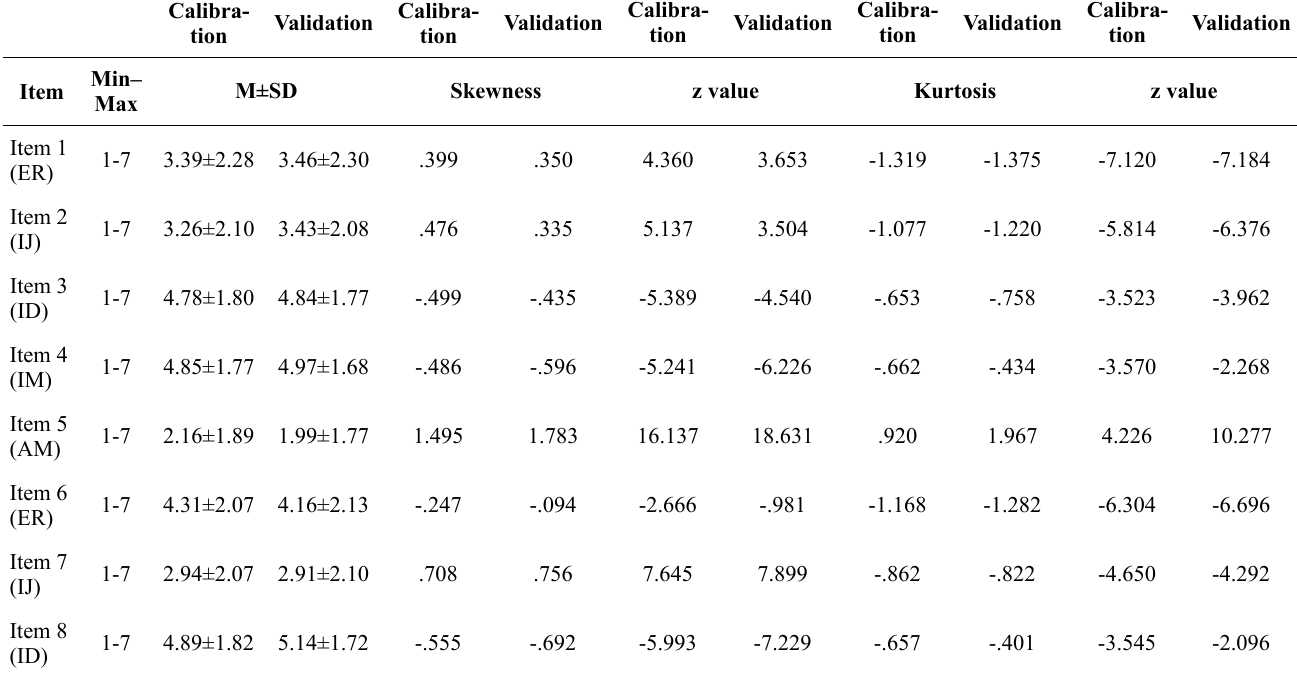
Table 1 Descriptive analysis of the answers to the items on the PLOCQ in the calibration and validation samples Calibra-